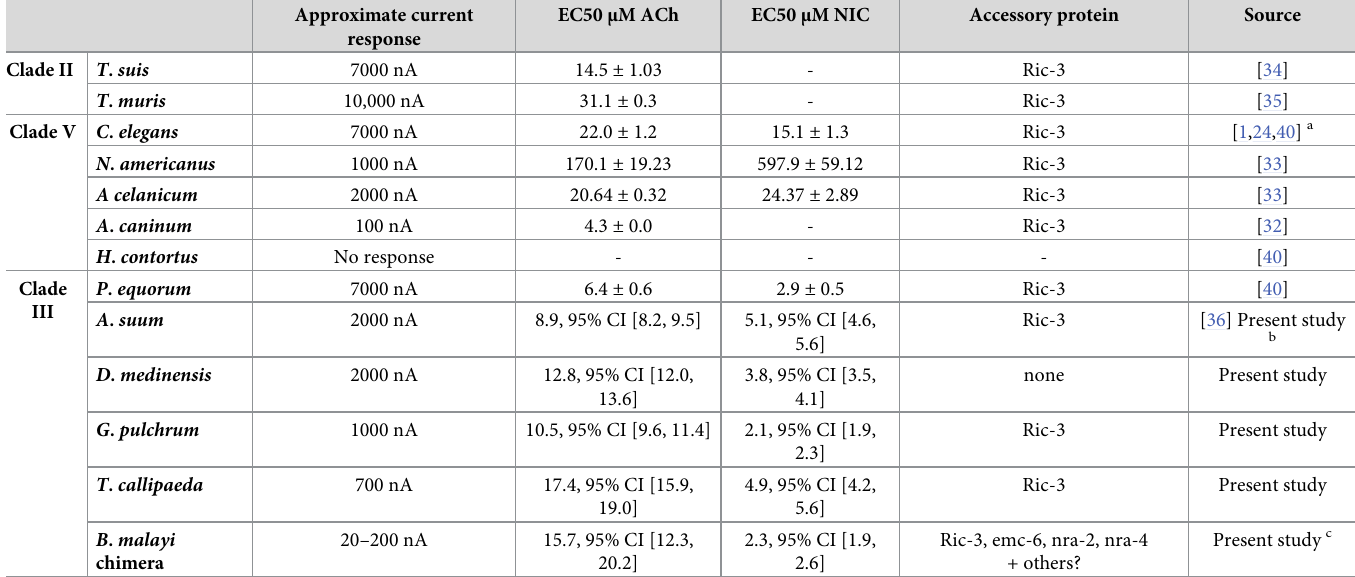
Table 1. Comparison of pharmacology and accessory proteins required for nematode